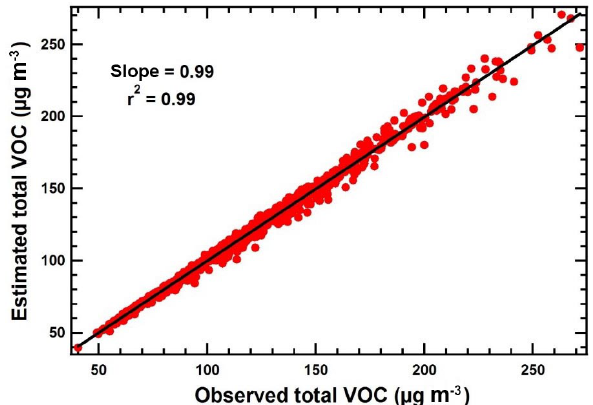
Figure 2. Correlation between estimated and observed NMVOC